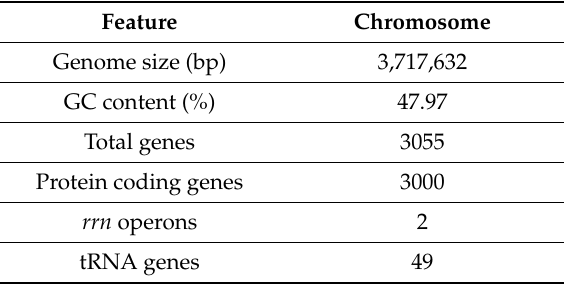
Table 1. General features of the Petrimonas mucosa ING2-E5A T